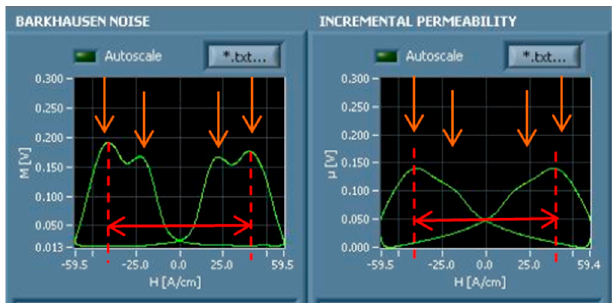
Figure 20. Barkhausen Noise (BN) signal (left) and IP signal of an AlSi ‐ coated PHS part; the characteristic double ‐ peak structure is clearly visible.